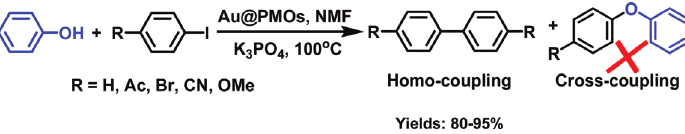
atoms are directly bonded to one O atom. The Au/CeO 2 model contains neutral Au 0 atoms on top of the rod and cationic Au δ+ sites at the metal-support interface. Mech- anistic studies showed that iodobenzene dissociation occurs on low-coordinated Au 0 atoms present in small gold particles (e.g., Au and Au O ), whereas phenyl- 38 38 2